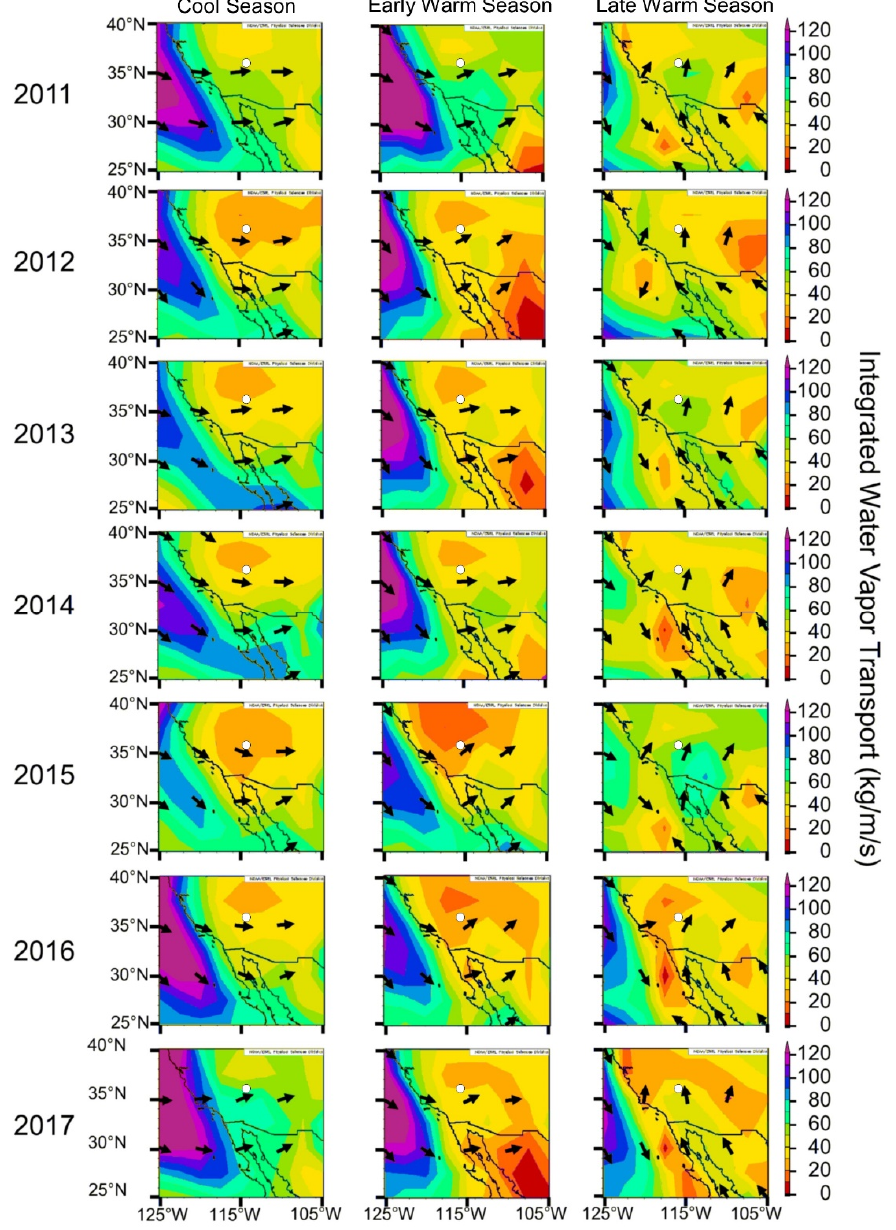
Figure 6. Seasonal averages of integrated water vapor transport (IVT) for the 2011–2017 water years. Pseudo-color shading with overlaid vectors (arrows) was used to indicate the amount of moisture and the direction of transport. Cool-season IVT, and resulting precipitation (Figure 3), was large in 2011, 2016, and 2017, as well as for the 2015 late warm season.